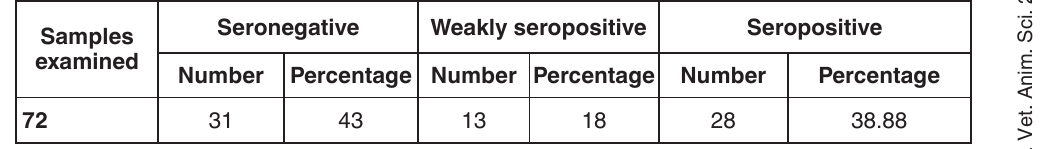
table 1. seroprevalence of T. gondii in aborted goats by elisa samples